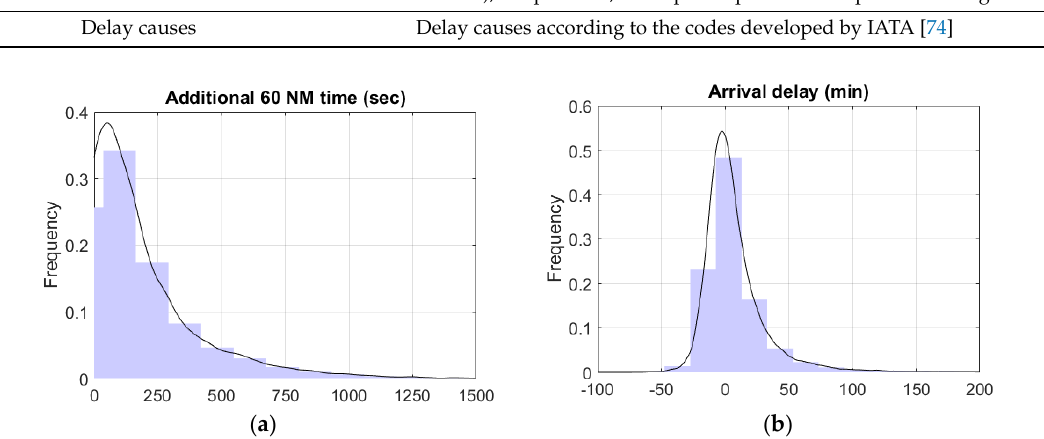
Figure 7. Histogram and distribution fitting for ( a ) additional time at ASMA 60 NM (s), ( b ) arrival delay (min). Aerospace 2018 , 5 , x FOR PEER REVIEW